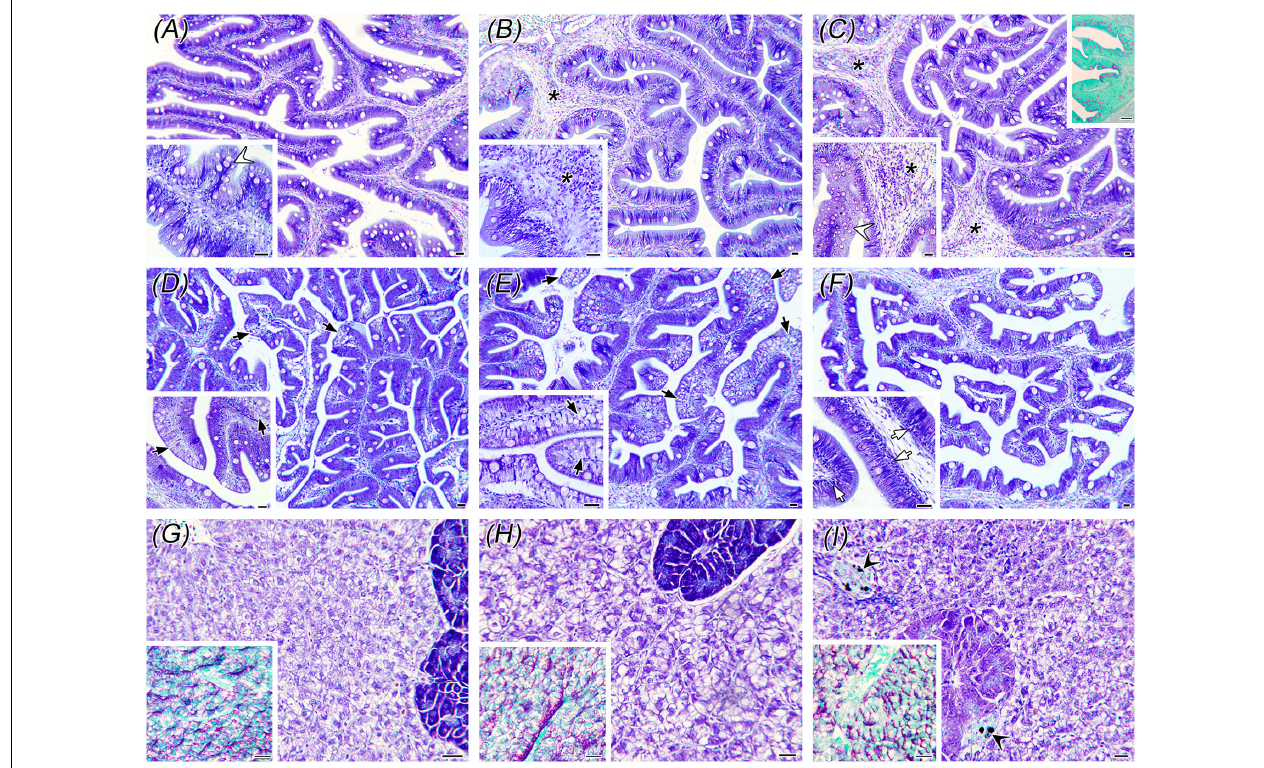
FIGURE 1 | Histological alterations in the AI (A–C) , PI (D–F) and liver (G–I) of gilthead sea bream. Panels (A , D,G) correspond to CTRL fish; (B,E,H) to fish fed the L-FM/FO diet; and (C,F,I) to fish fed the EWH diet. In AI, note the high abundance of light-stained goblet cells (white arrowheads) in CTRL (A) and EWH (C) fish, as well as the submucosal hyperplasia (asterisks) in L-FM/FO (B) and EWH (C) fish. The upper insert in panel (C) shows the PAS-stained goblet cells. In the PI, note the presence of lipid vacuolization in enterocytes (black arrows) in CTRL fish (D) , which is intensified in L-FM/FO fish (E) and decreased in EWH fish (F) . PI of EWH fish presented high abundance of intraepithelial lymphocytes (white arrows). In livers, note the higher lipid storage in L-FM/FO fish (H) and the presence of early melanomacrophage centers (black arrowheads) in EWH fish (I) . Glycogen storage did not change among groups (PAS-stained inserts). Scale bars = 20 µ m.